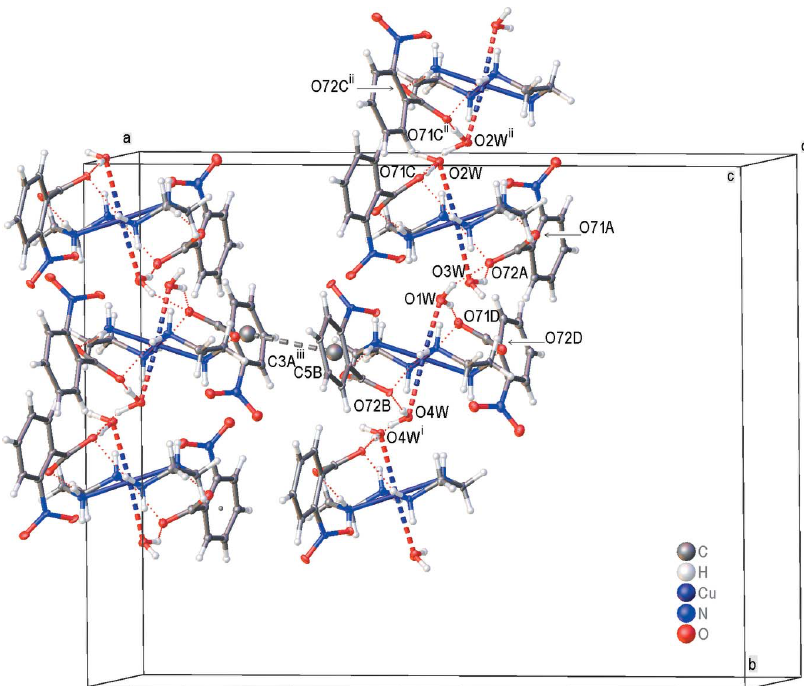
Figure 2 Aview of the crystal packing of the title complex with only the major component of disorder shown and fine red dotted lines indicating hydrogen bonds (Table 2). Displacement ellipsoids are drawn at the 50% probability level [symmetry codes: (i) x , 1 (cid:5) y , (cid:5) 1